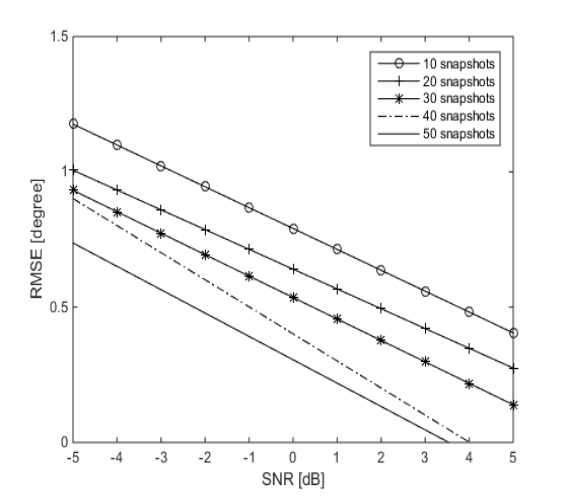
Figure 16. MVDR A-LASSO DOA estimation performance versus the number of snapshots, two source signals with DOAs 60 ◦ and 120 ◦ , γ = 0.5.